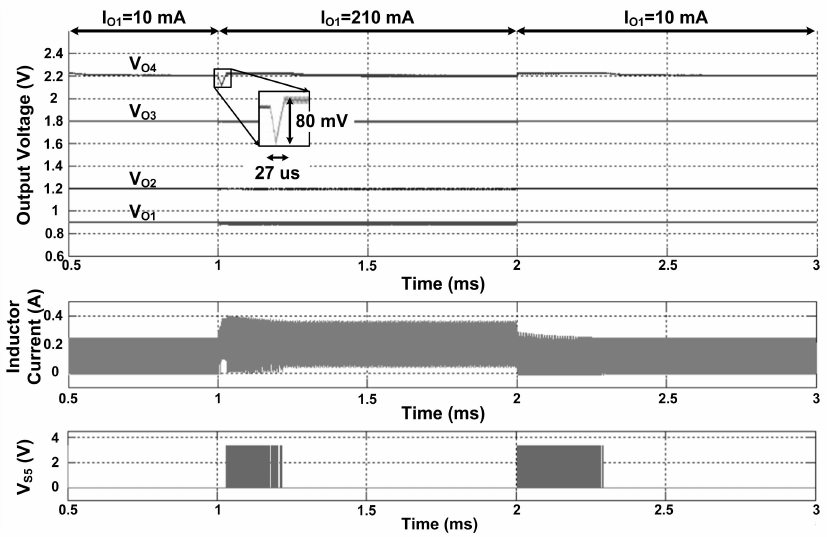
Figure 12. Simulation results at the load transition of output one with the hybrid control